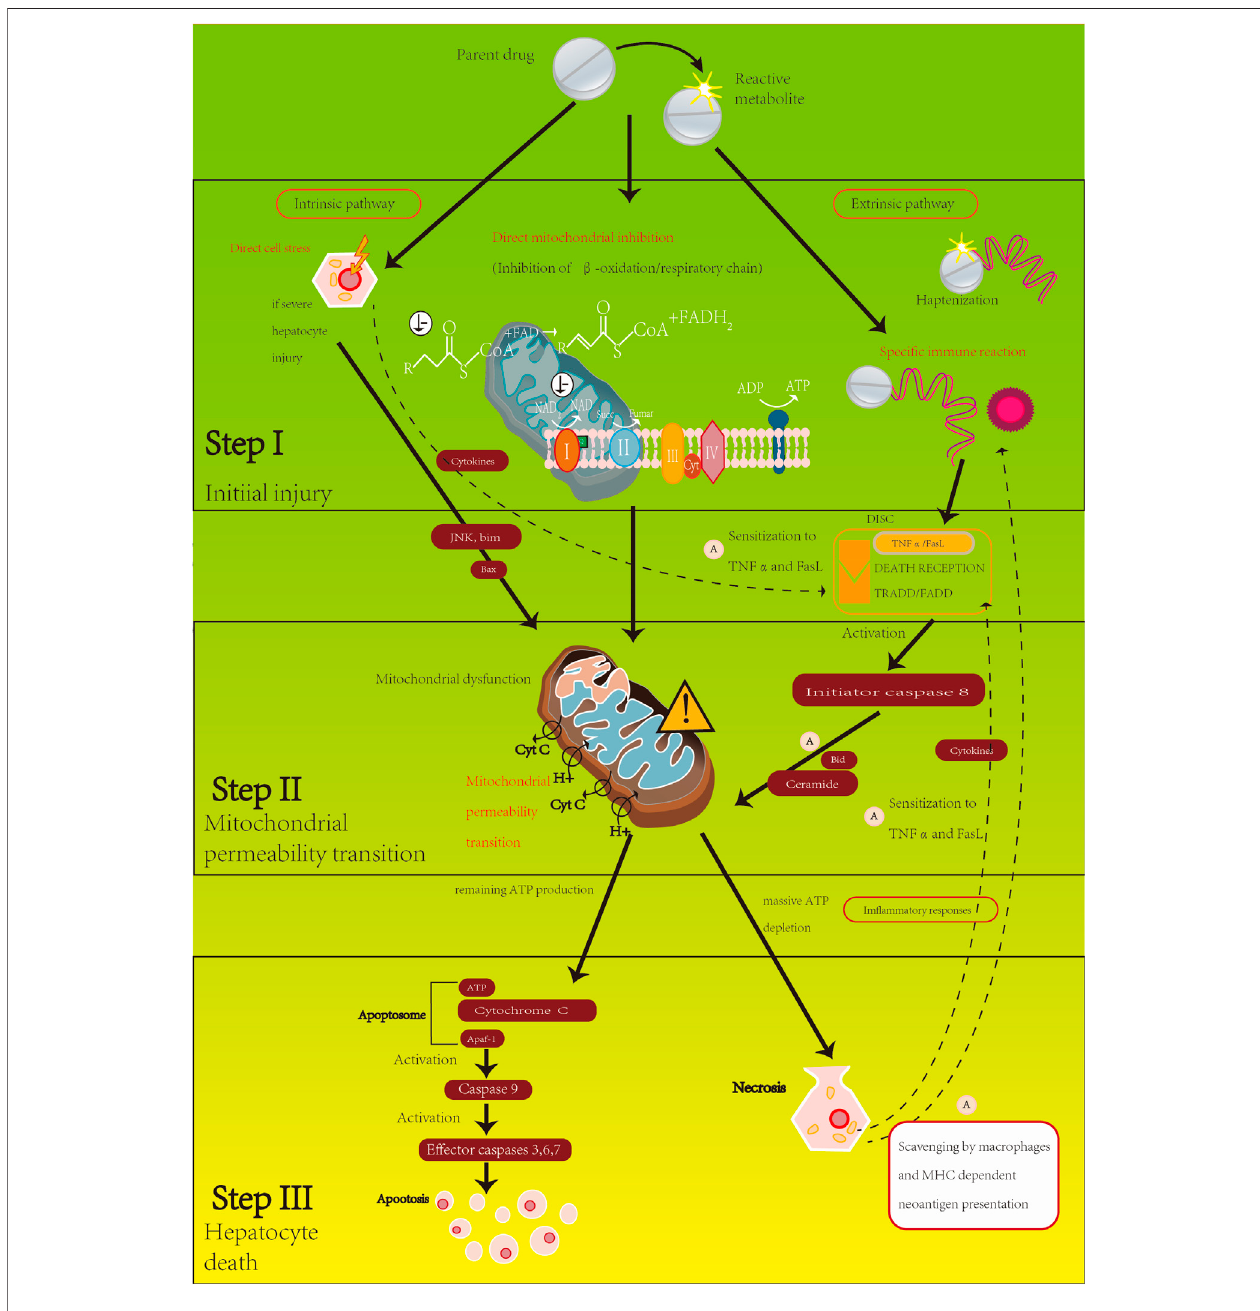
FIGURE 1 | Pathogenesis of